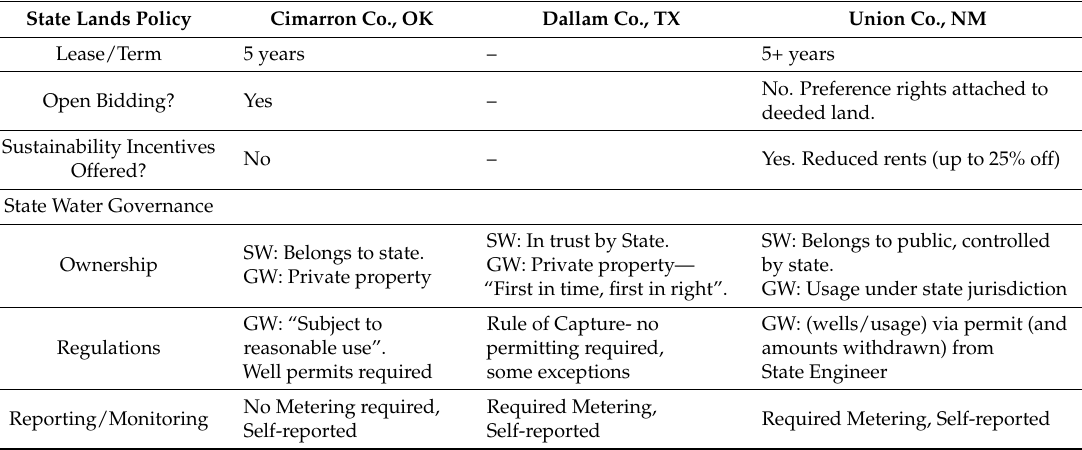
Table 2. Formal land and water governance in the tri-state, three-county study area. State Lands